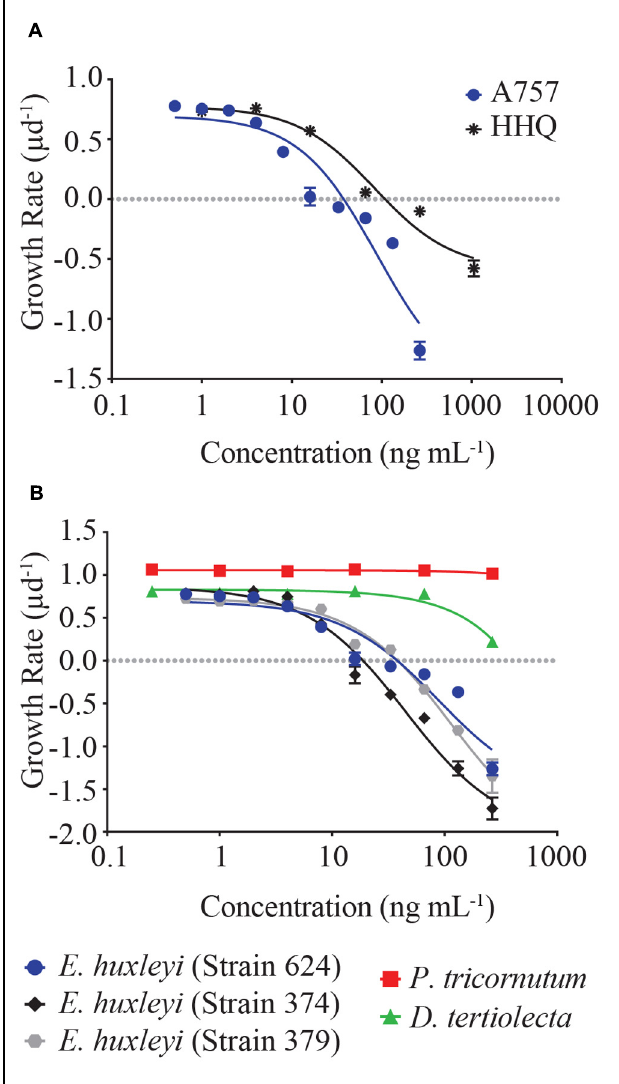
FIGURE 3 | (A) Dose-response comparison of E. huxleyi (strain 624, axenic) growth rate in response to a gradient of extracted (labeled A757) and reference HHQ. (B) Dose-response curves of five different strains of phytoplankton in response to HHQ extracted from P. piscicida . Each symbol represents the mean of three independent replicates ± the standard deviation. IC50 values were calculated for each curve (see Table 1 ).